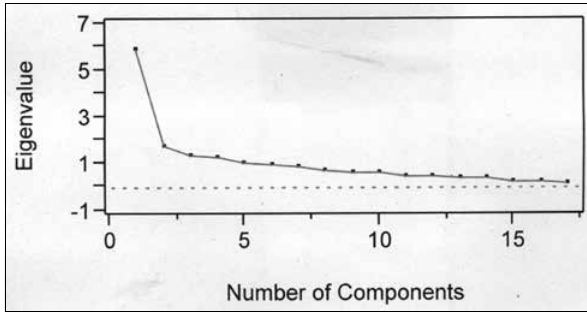
Figure-3: Scree plot showing component number with Eigen